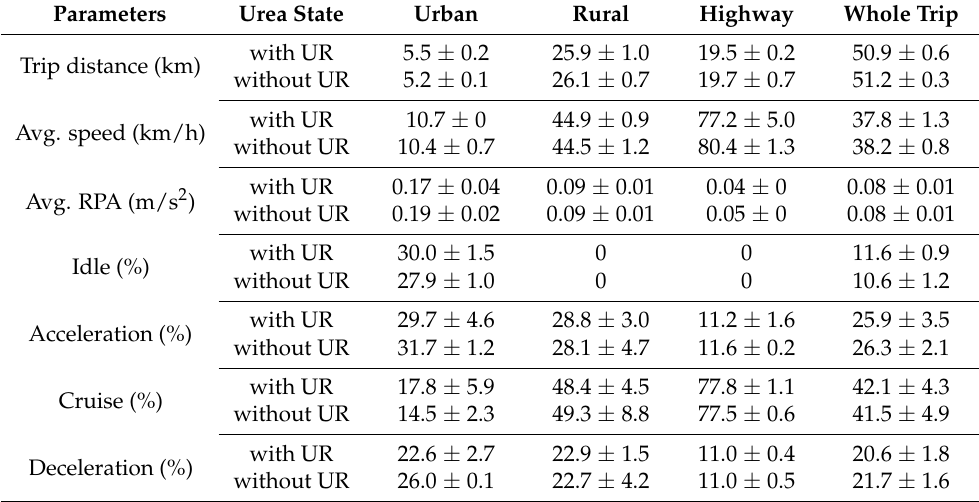
Table 2. Driving